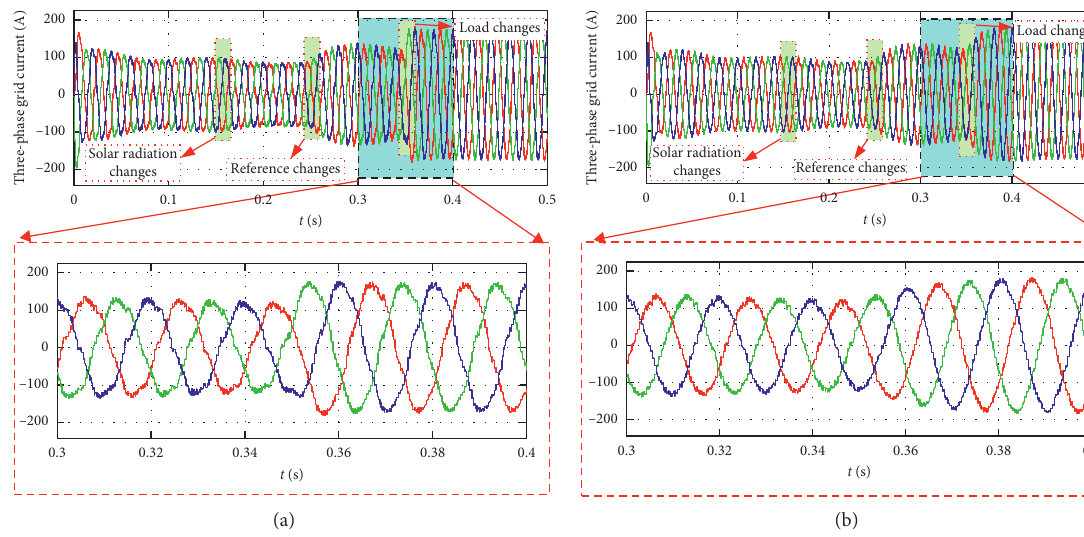
Figure 10: Three-phase grid current of the grid-connected system. (a) PV. (b) PV+APF.